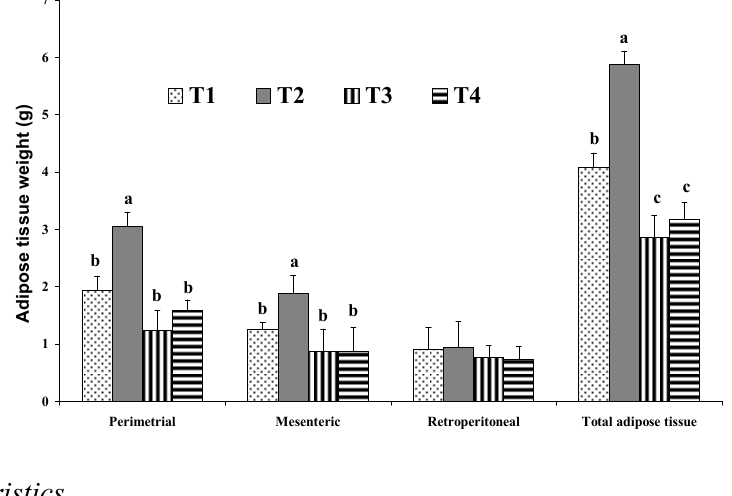
Figure 3. Effect of binding of conjugated linoleic acid with biopolymers on adipose tissue weights in mice fed high- and low-fat diets. Significance was set at p < 0.05.